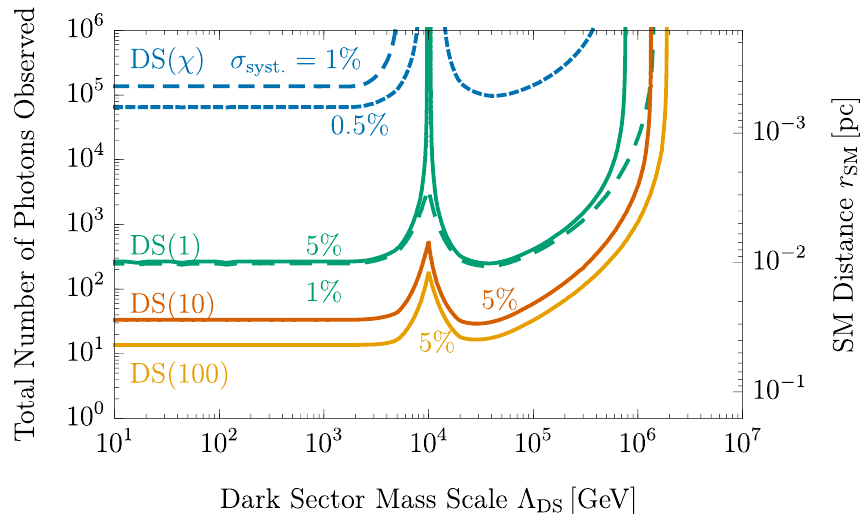
Figure 5: Projected 2 σ exclusion limits for a range of dark sector models, for differ- ent systematic errors. The search assumes that a given total number of photons is observed between 10 − 4 and 10 3 s, with a SM-like spectrum. The distance to the EBH, assuming only the SM, is given by the right